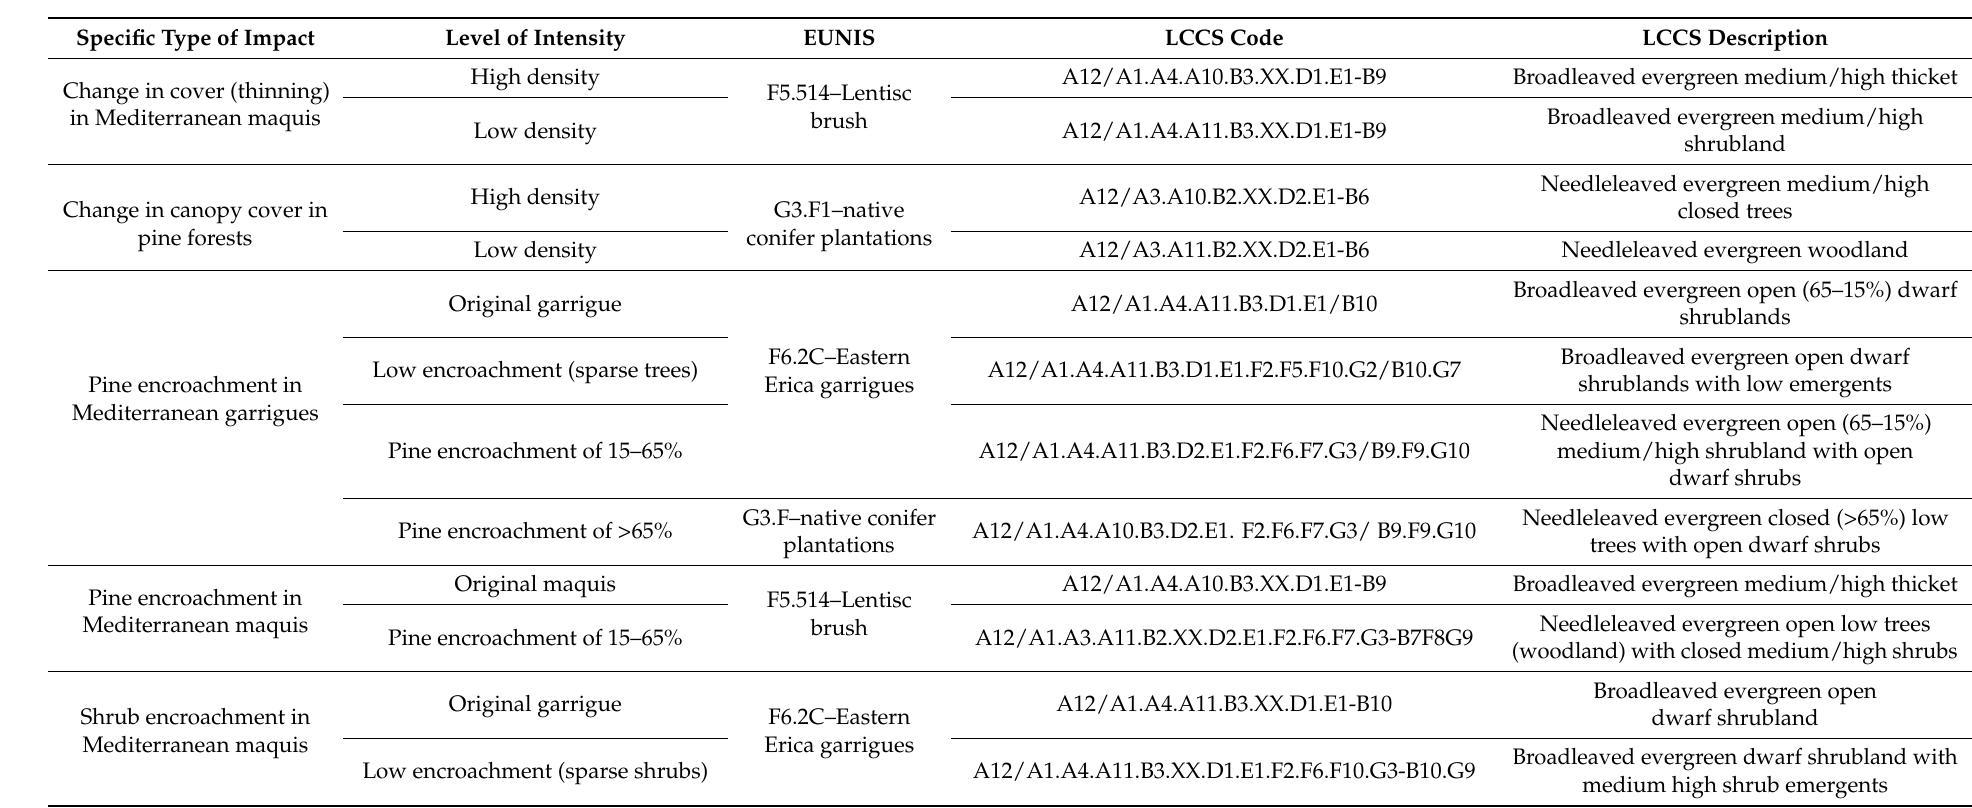
Table 5. A list of the different types of change at different levels of intensity affecting various types of forest vegetation observed in the two study areas (“Specific type of impact” column). For each type of change/degree of intensity, the corresponding class type is reported for EUNIS and LCCS. As regards the woody vegetation types surveyed in this contribution, LCCS allows the representation of some structural changes (e.g., cover or